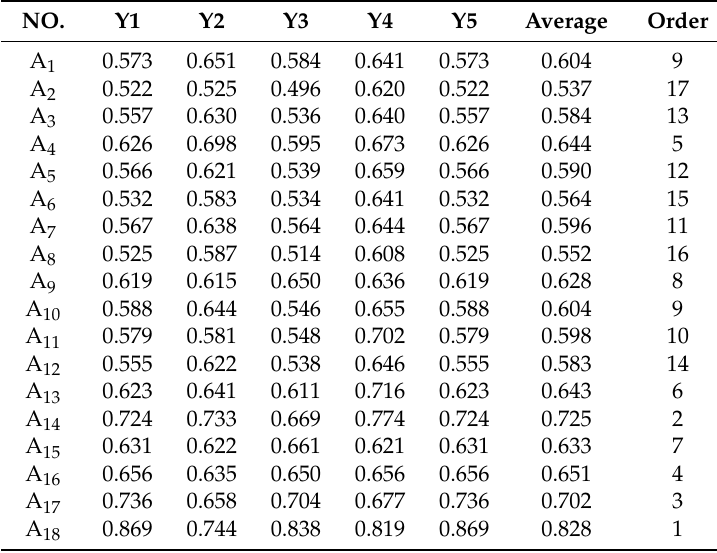
Table 4. The calculated grey relational coefficient and grey relational grade for 18 comparability sequences and their